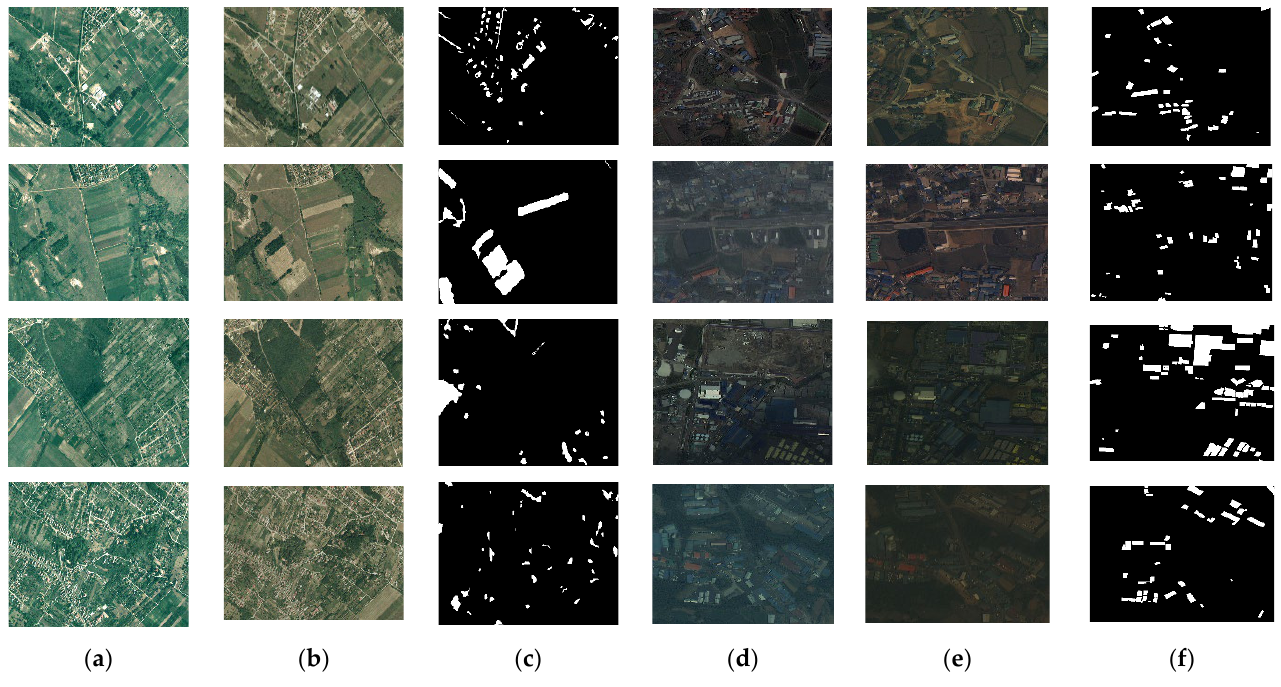
Figure 3. Indicative images from ( a – c ) the SZADA dataset and ( d – f ) the side-looking dataset: ( a , d ) image at time t1; ( b , e ) image at time t2; and ( c , f ) reference change map.